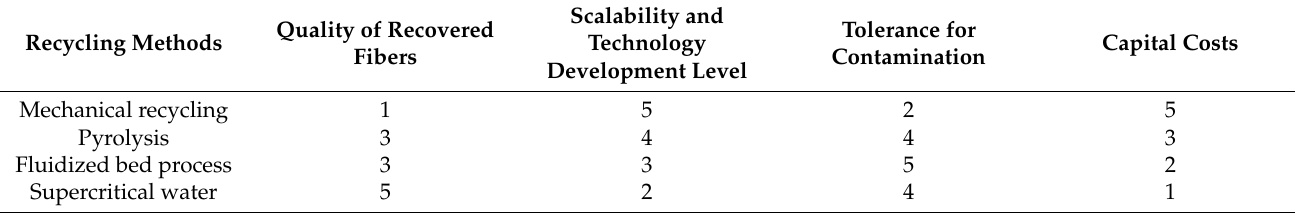
Table 6. Quantified values for user